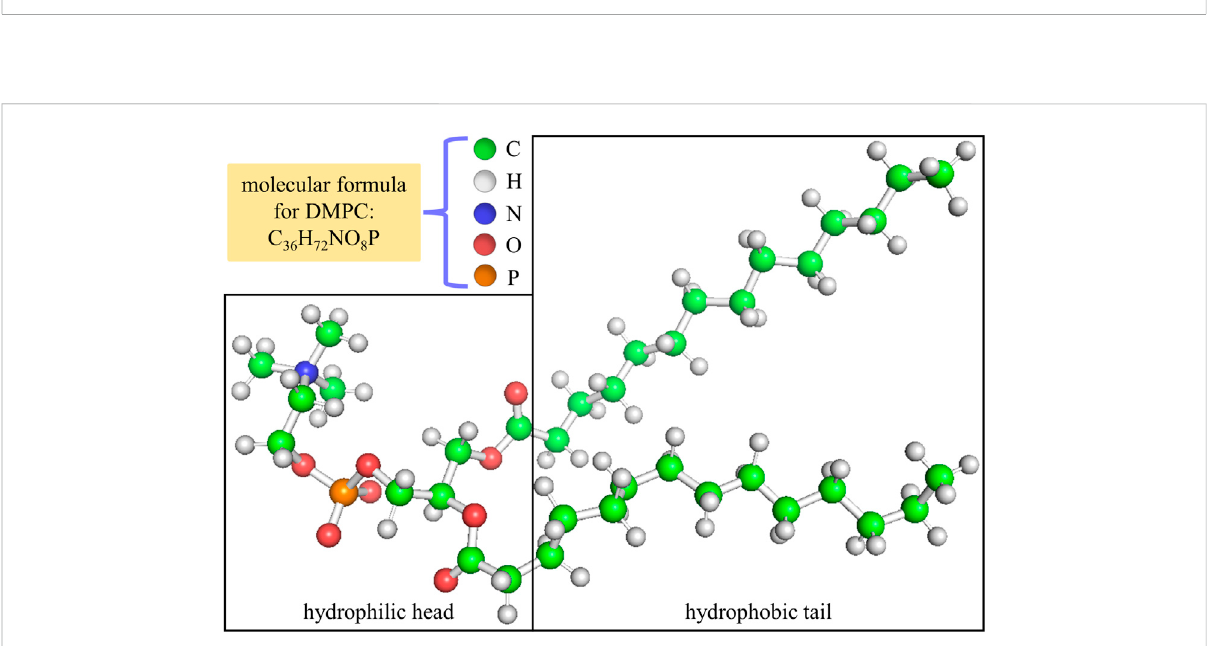
Position of the dividing line between the hydrophilic head and the hydrophobic tail in a DMPC molecule.